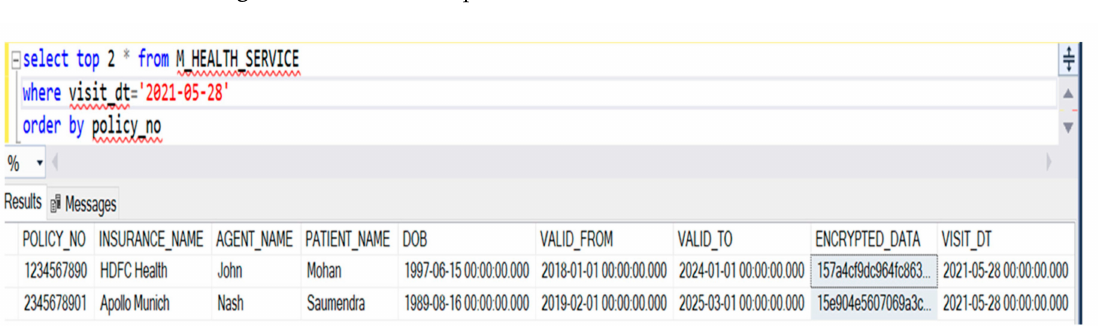
Figure 13. The insert scripts of the data